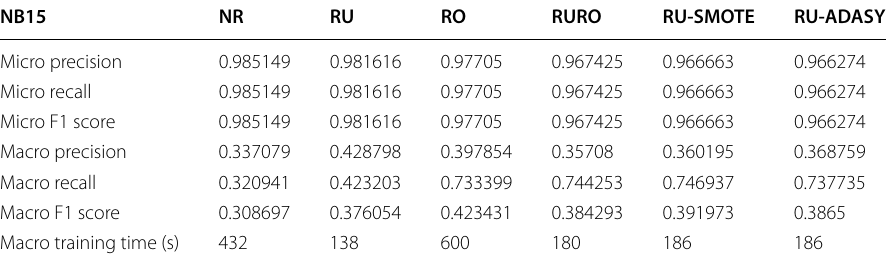
Table 20 ANN Classification results for UNSW-NB15 on AWS with Spark for various resampling methods